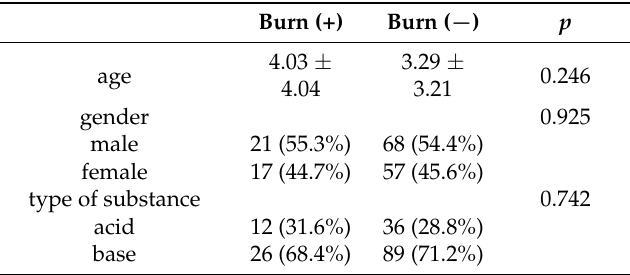
Table 2. Demographic features of the patients.